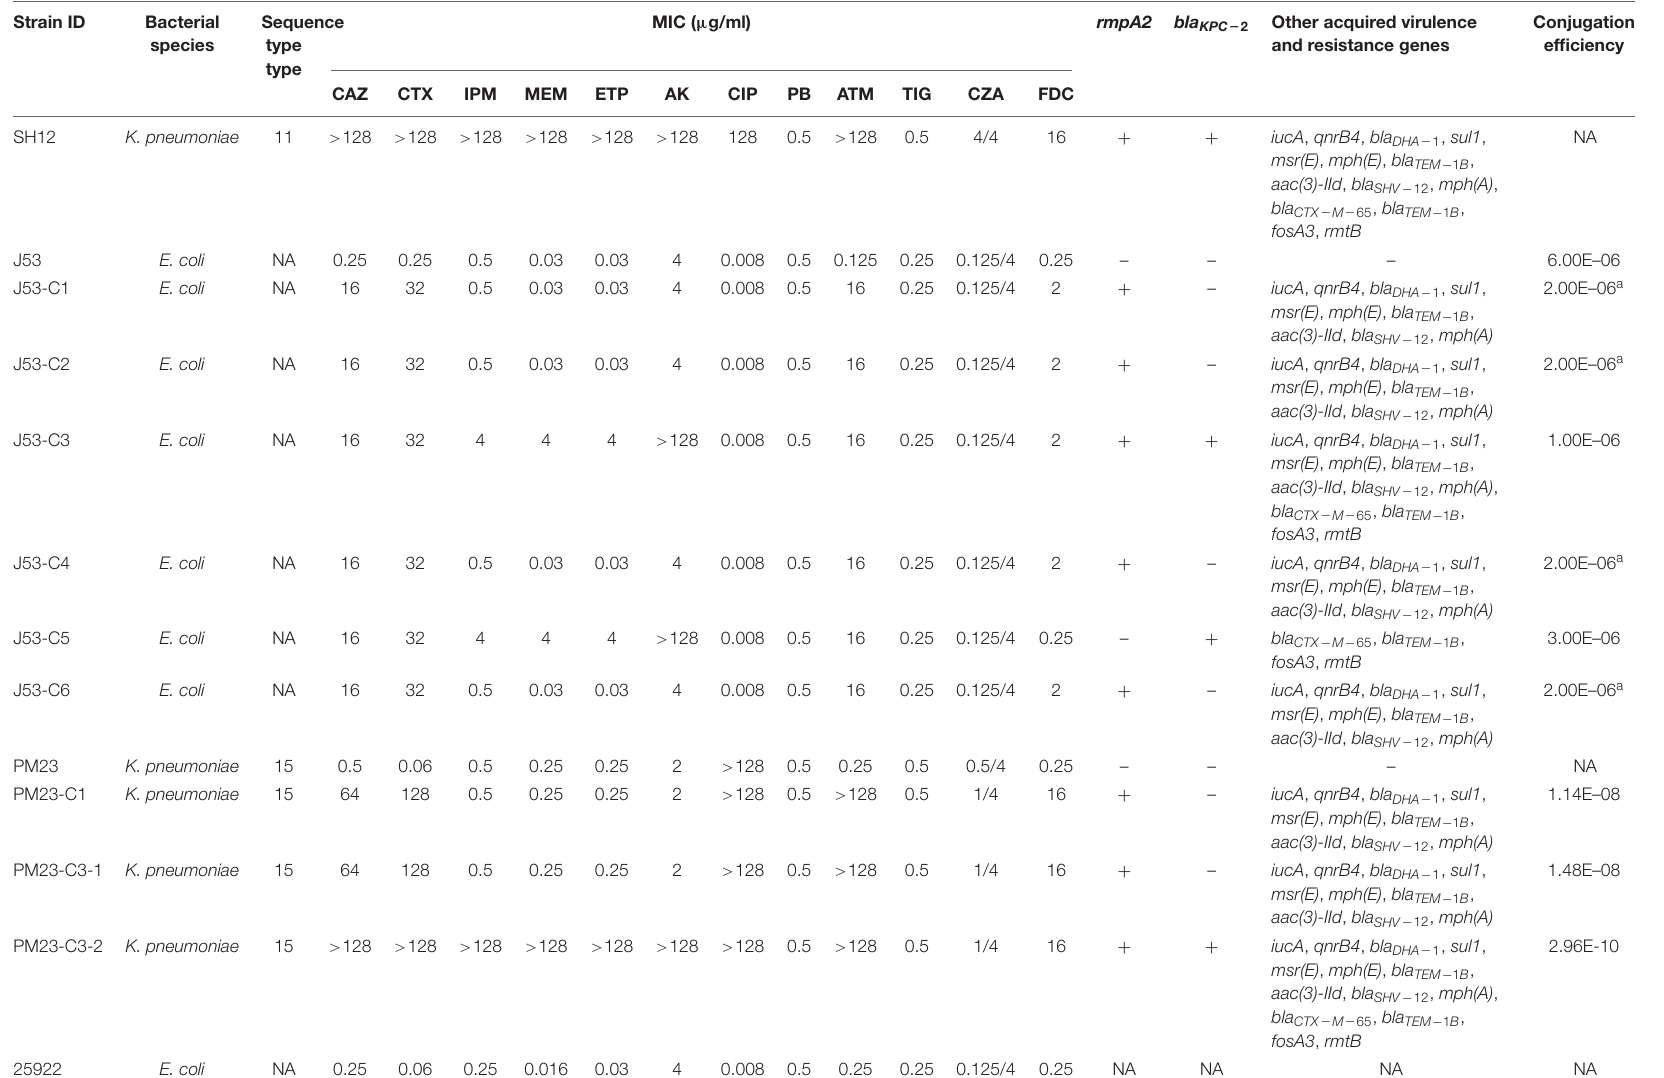
TABLE 1 | Phenotypic and genotypic characteristics of K. pneumoniae strain SH12 and its transconjugants. Strain